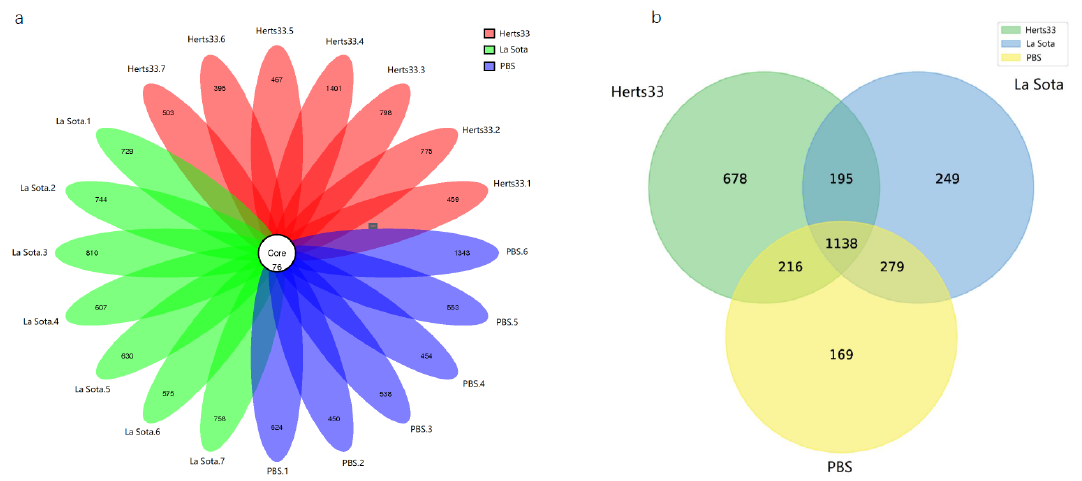
Figure 1. The community composition analysis. ( a ) Venn diagram showing overlap in OTUs of differential abundance of each sample in Herts33, La Sota and PBS groups. ( b ) Venn diagram showing overlap in OTUs of differential abundance in Herts33, La Sota and PBS groups.